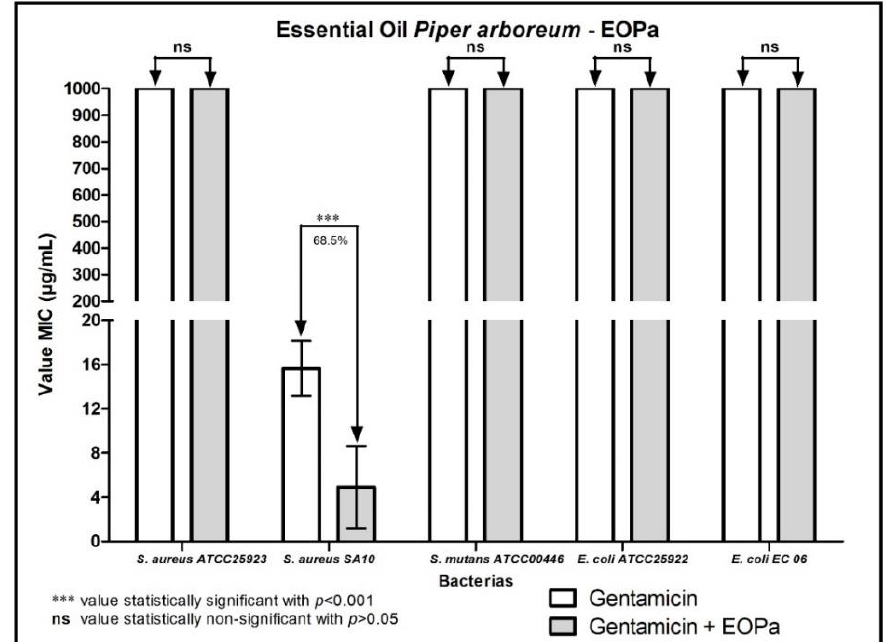
Figure 4 Evaluation of the modulatory activity of EOPa combined with gentamicin against bacterial strains.